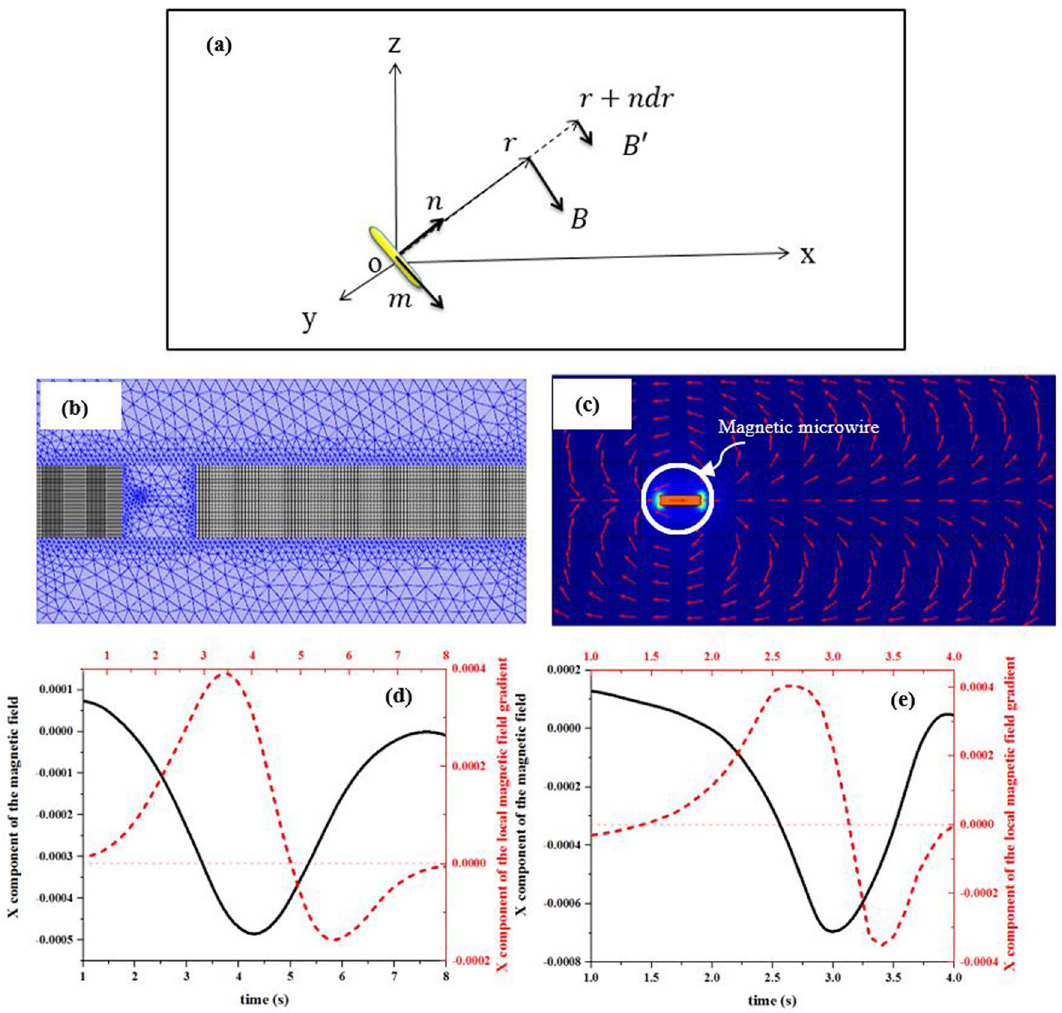
−→ m Figure 4. ( a ) The location of the magnetic dipole of relative to the atomic magnetometer. ( b ) Moving and mapped mesh for stationary and linearly translating domains, respectively, and ( c ) magnetic field lines created around the magnetic microwire. Simulation of the magnetic field and local magnetic gradient of the moving magnetic microwire with ( d ) constant and ( e ) variable velocity using COMSOL Multiphysics 5.4 53